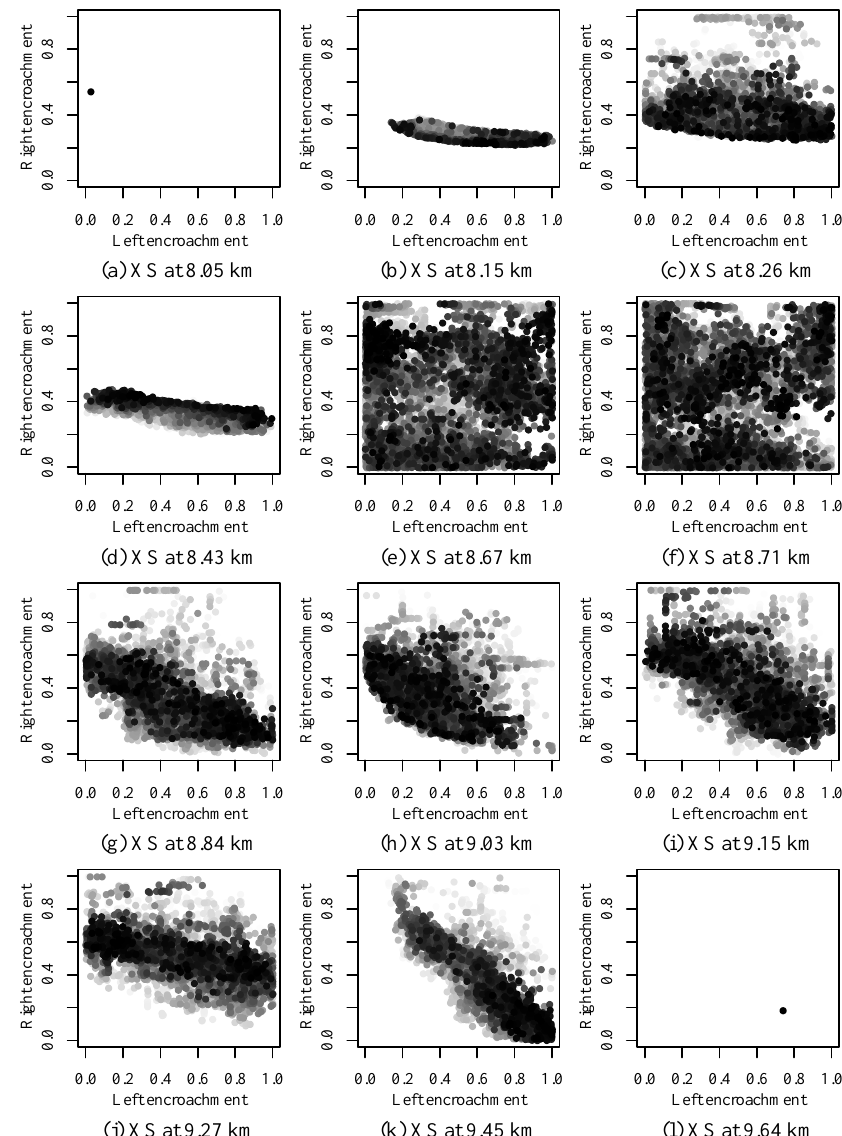
[ 0,1 ] D for 1 i S satisfying ∈ ≤ ≤